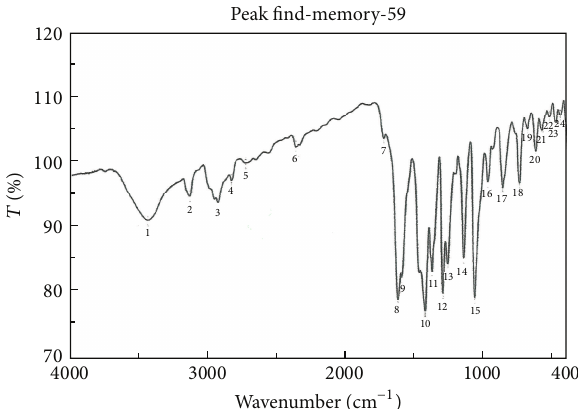
Figure 1: The FTIR spectra of EEDB